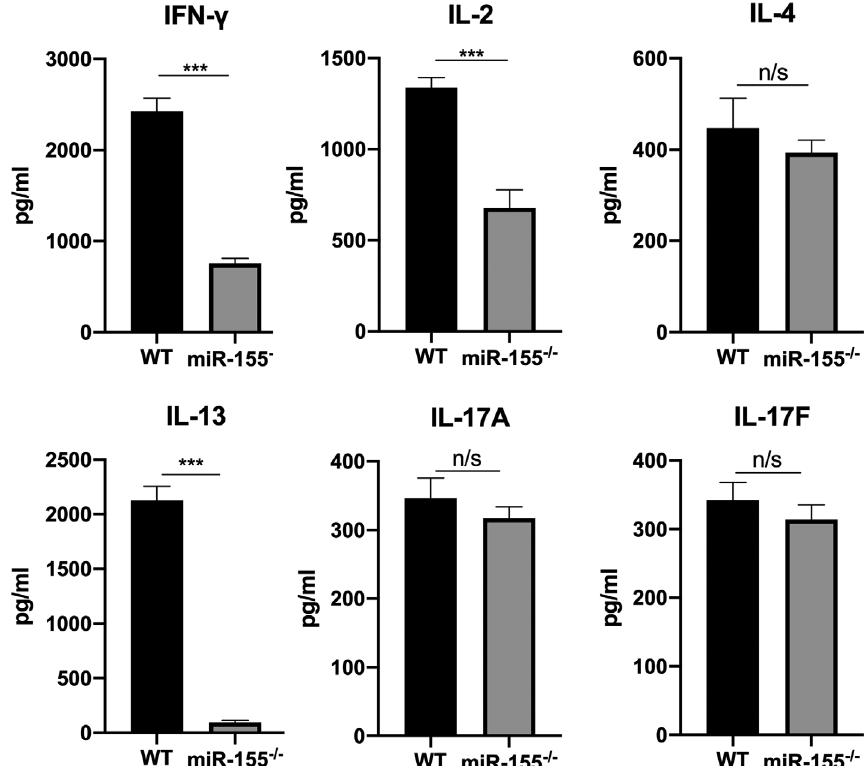
Figure 2. Evaluation of Th-1\Th-2\Th-17 immune responses in WT and miR-155 (cid:1) / (cid:1) mice. The levels of IFN- c , IL-2, IL-13, IL-4, IL-17A and IL-17F were measured from splenic lymphocytes of WT- and miR-155KO-infected mice. Signi fi cant decreases in IFN- c , IL-2, IL-13 were observed in miR-155 (cid:1) / (cid:1) mice. Data are shown from one representative experiment of three independent experiments and presented as a mean ± SD. *** p < 0.001; N/S = not signi fi